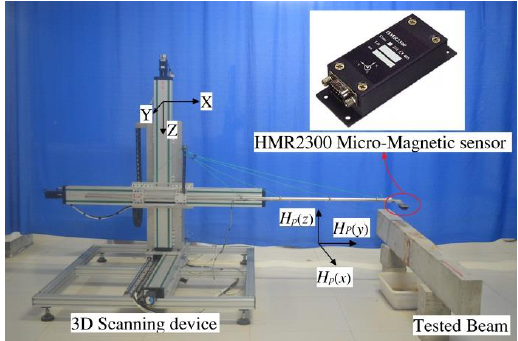
Figure 3. The 3D scanning device for magnetic field measurement.